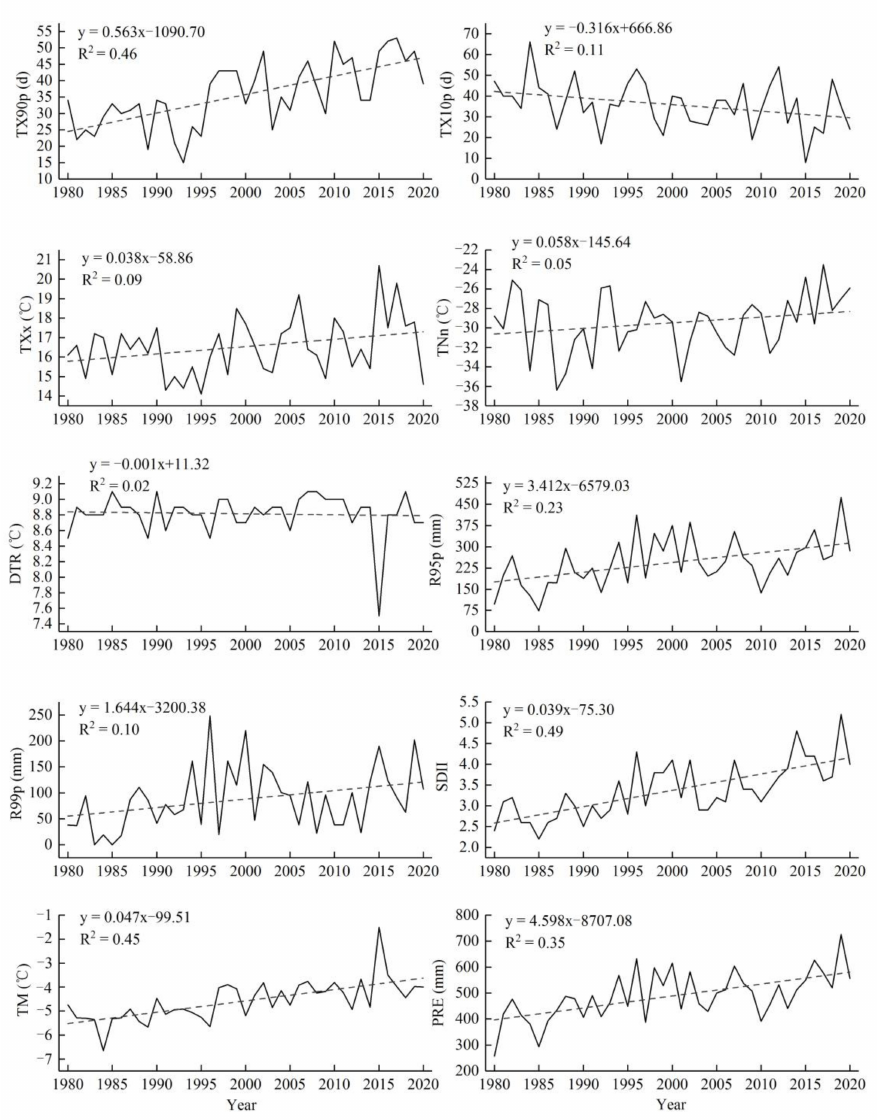
Figure 4. Liner trend in extreme climate indices during 1980–2020. The solid lines denote linear